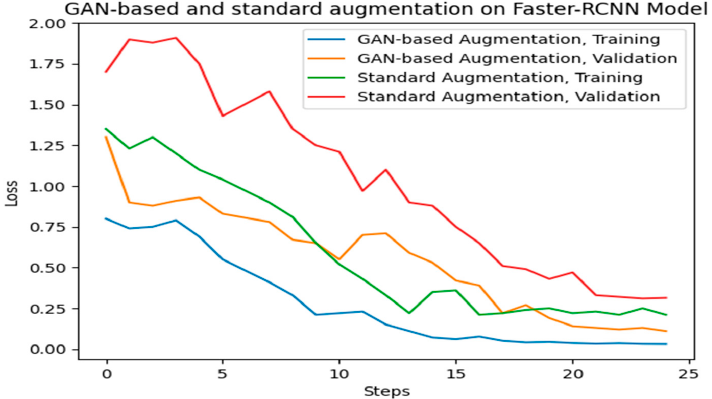
Figure 13. Training and validation losses between the proposed augmentation pip line and the standard augmentation method on Faster-RCNN.